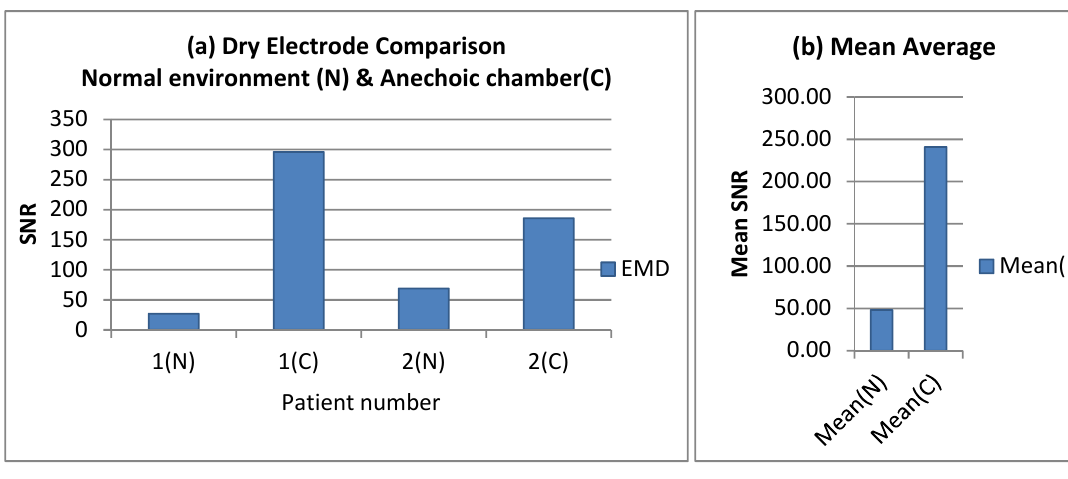
Figure 8. ( a ) SNR of dry electrode, charge amplifier recordings, ( b ) Mean average of both subjects ( N =